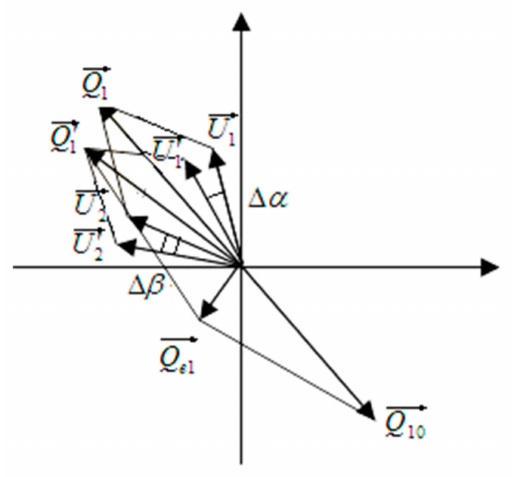
Figure 5. The radial position error of the balance